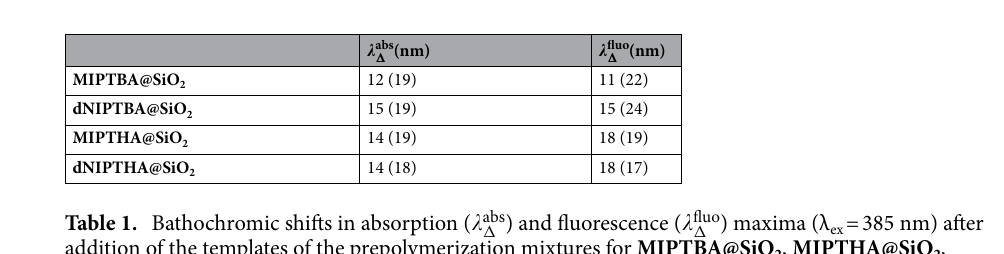
Table 1. Bathochromic shifts in absorption ( (cid:31) addition of the templates of the prepolymerization mixtures for MIPTBA@SiO 2 , MIPTHA@SiO 2 ,